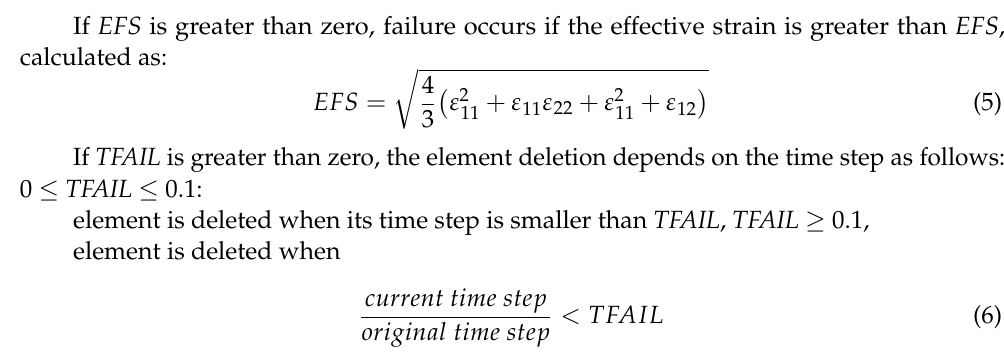
Figure 7. Chang-Chang Failure Criteria.